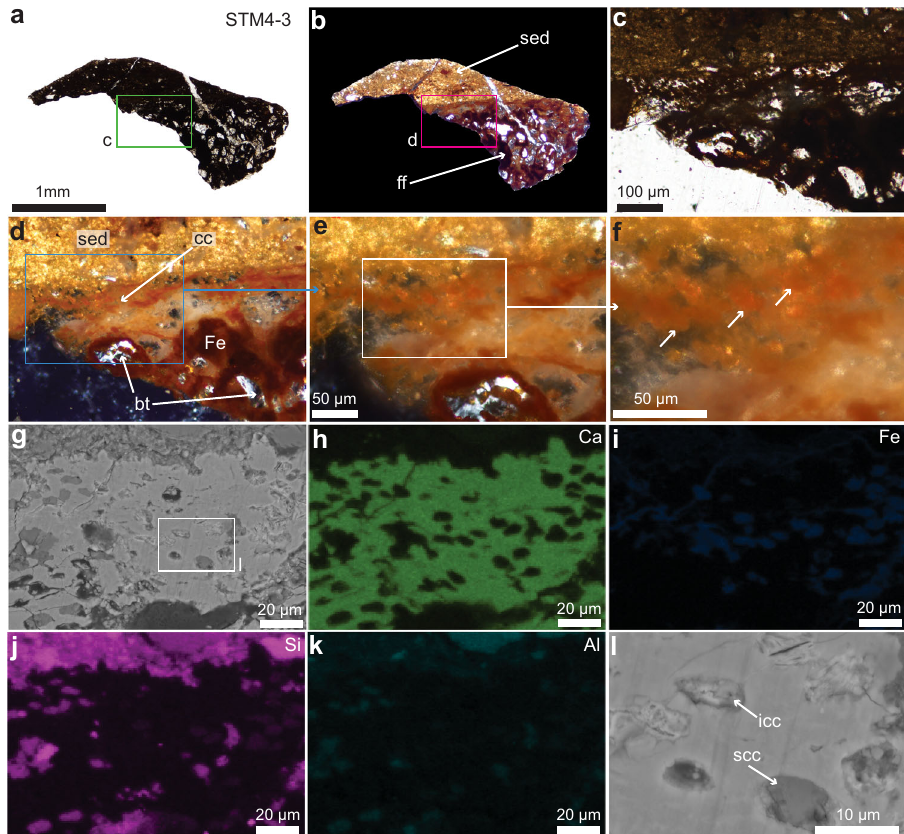
Fig. 2 Photographs of a fragment of the articular cartilage of STM4-3 seen with multiple microscopy methods. a Femur fragment (ff) seen under transmitted light. b Fragment seen under the polarized light. c Close-up of the fragment (green box in a ) showing dark tissues and overlying sediment. d Close-up of the fragment (pink box in b ) seen under overexposed polarized light, showing sediments (sed), calci fi ed cartilage (cc), and a few subchondral bone trabeculae (bt) that are birefringent. The two tissues are in fi ltrated with an orange to dark red material mostly composed of iron (Fe). e A close-up on the cartilage reveals that a lot of the chondrocyte lacunae are fi lled with the orange iron material. f Close-up of the white box in e, with arrows pointing at a few chondrocyte lacunae. g SEM image of approximately the same area shown in e, showing calci fi ed cartilage with chondrocyte lacunae fi lled with 2 types of material: a dark gray material and a lighter material. h – k EDS analysis on this same image ( g ) showing the calcium (Ca) of the extracellular matrix, a group of chondrocyte lacunae fi lled with Silicon (Si) and Aluminum (Al), and another group with lacunae that are fi lled with iron (Fe). l Close-up of the white box in ( g ) showing ironized cartilage cells (icc) and silici fi ed cartilage cells